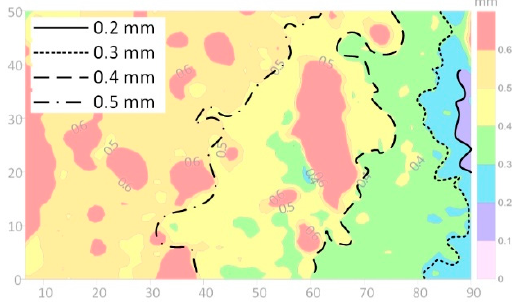
Figure 13. The front edges of the plugging zone with different particle sizes.